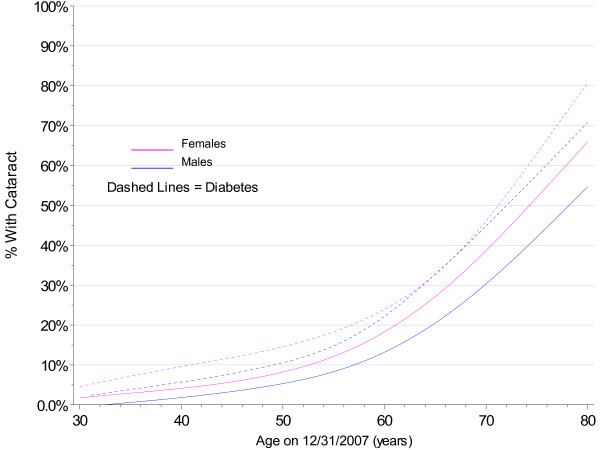
Smoothed 2007 Prevalence of Cataract by Gender and Diabetes.